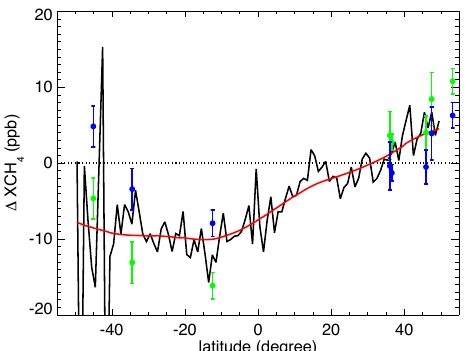
Fig. 3. Latitudinal variation of residuals between TCCON and co-located SCIAMACHY retrievals (green) and residuals between SCIAMACHY and GOSAT (black) using data from June 2009 to June 2010. The red curve is a box car smoothed version of the black curve, which is used to correct SCIAMACHY, resulting in the resid- uals with TCCON shown in blue.